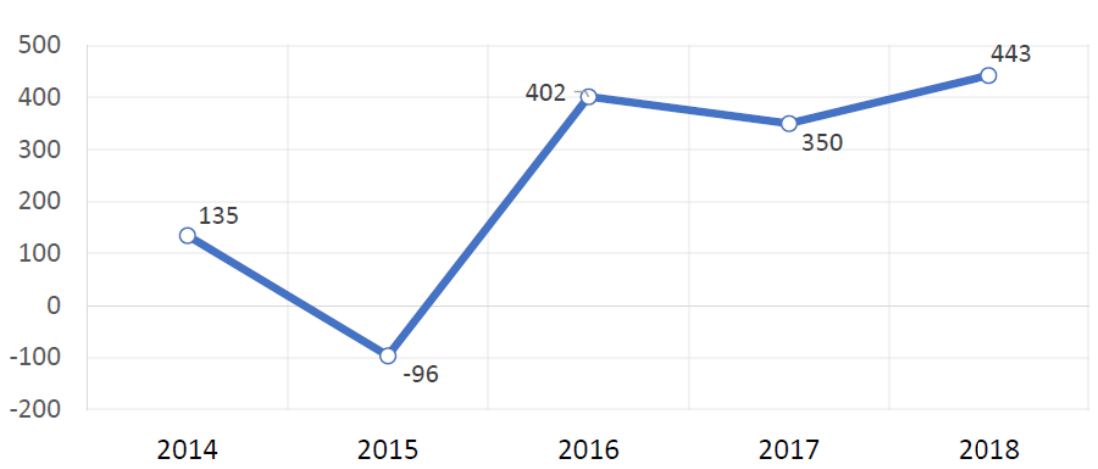
Figure 8: Earnings before taxes of STRABAG (CZK million), (source: Annual report of STRABAG 2014-2018, data processed by the authors)